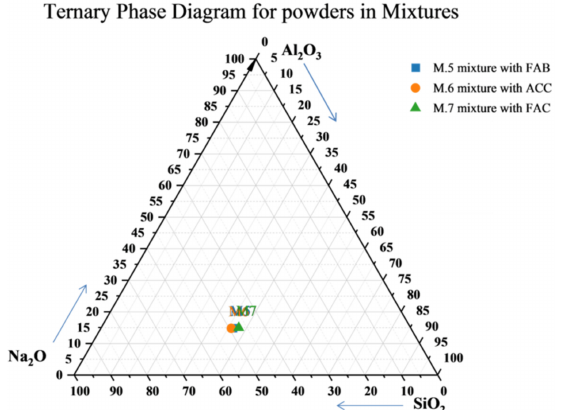
Figure 11. Ternary phase diagram of mass ratios for Na 2 O/Al 2 O 3 /SiO 2 oxides in components used for mixture preparation.